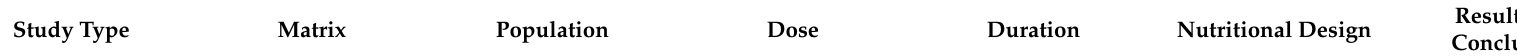
Table 5. Selected studies for the comparison between grapes and their by-products as a source of phenolic